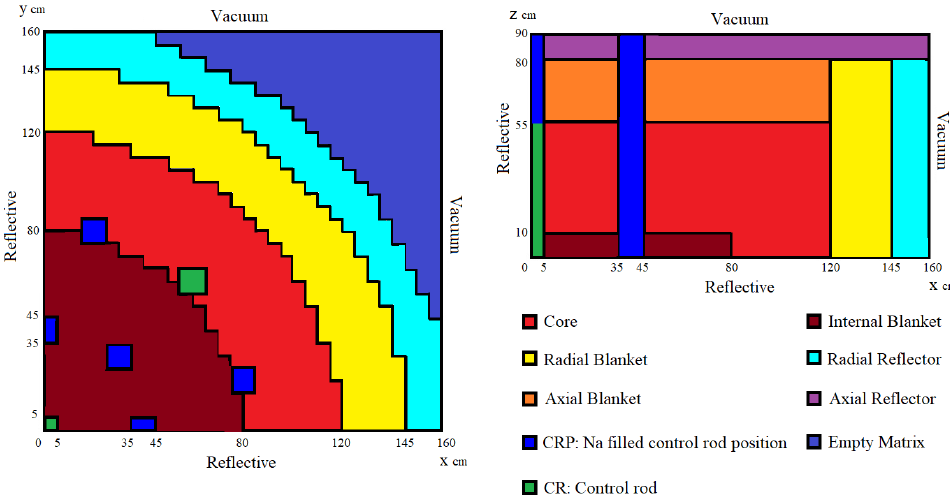
Figure 6. Core configuration of axially heterogeneous FBR